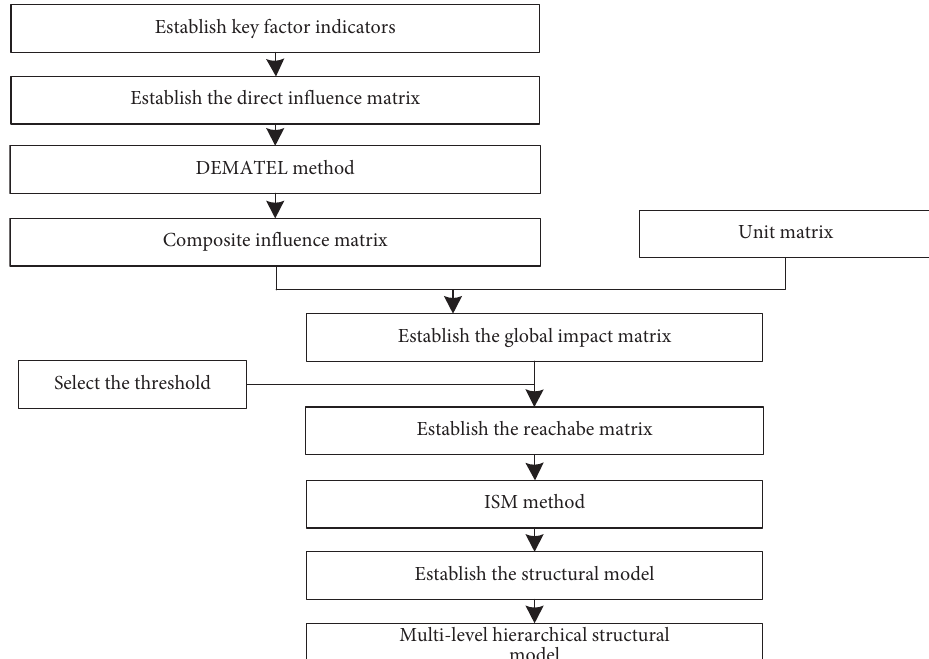
Figure 2: The integrated DEMATEL-ISM